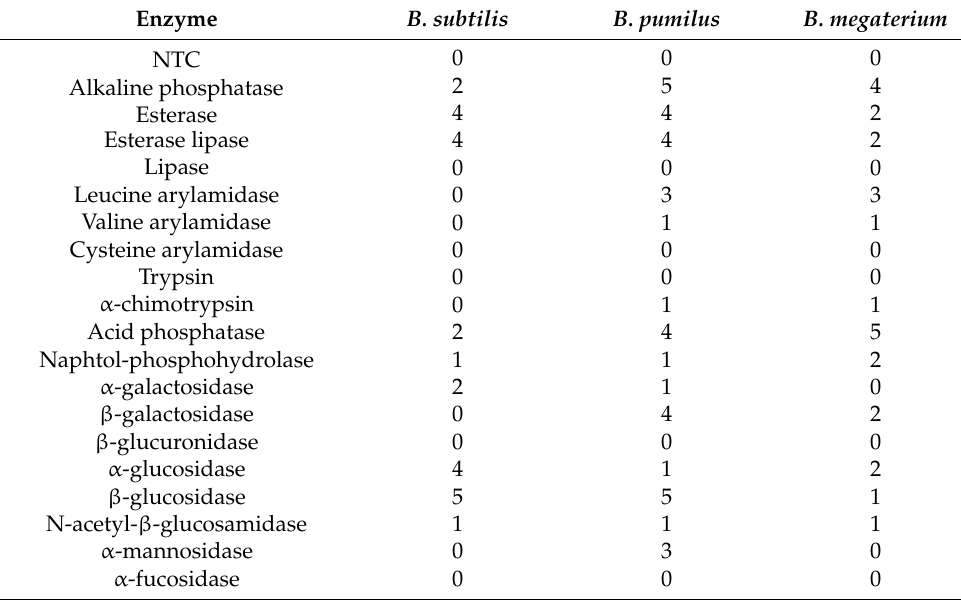
Table 2. Enzymatic activity of PCHS- Bacillus strains